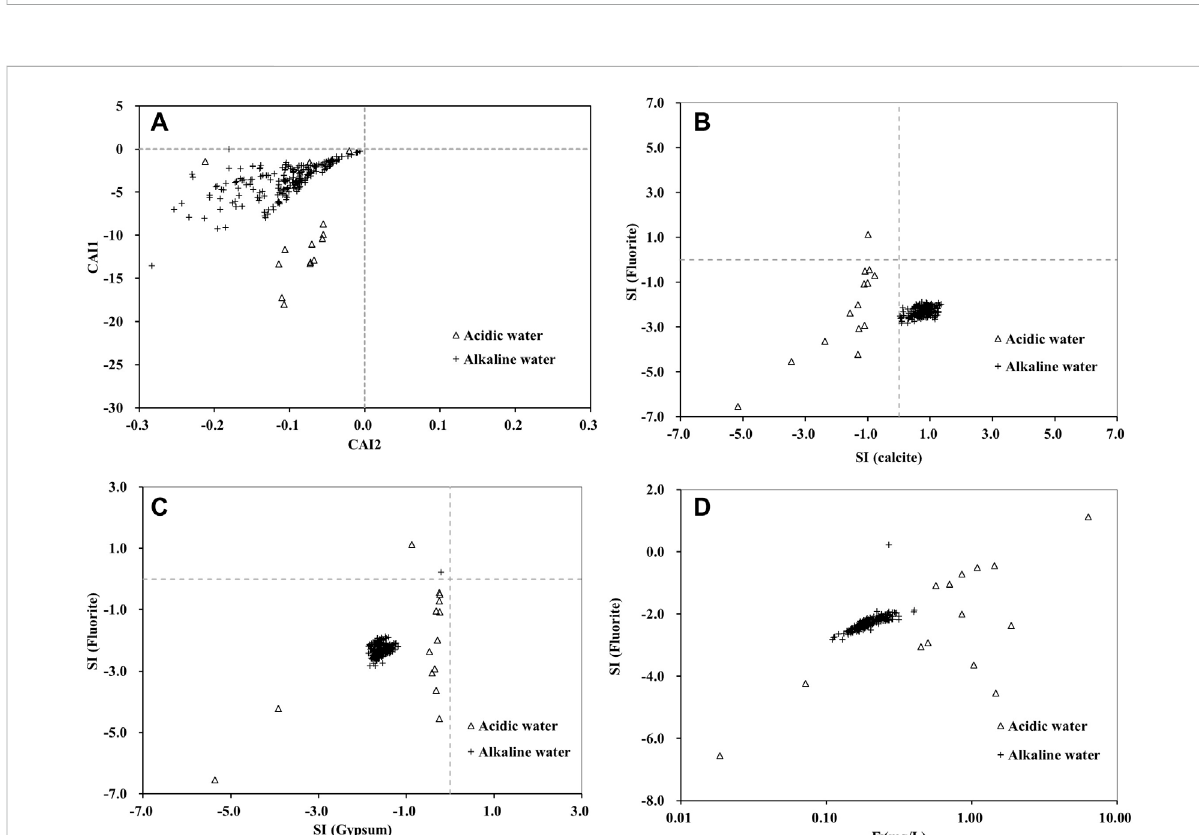
FIGURE 7 Plots of (A) CAI-1 versus CAI-2 used to describe cation exchange; (B) calcite saturation index versus fl uorite saturation index; (C) fl uorite saturation index versus gypsum saturation index; (D) fl uorite concentration versus fl uorite saturation